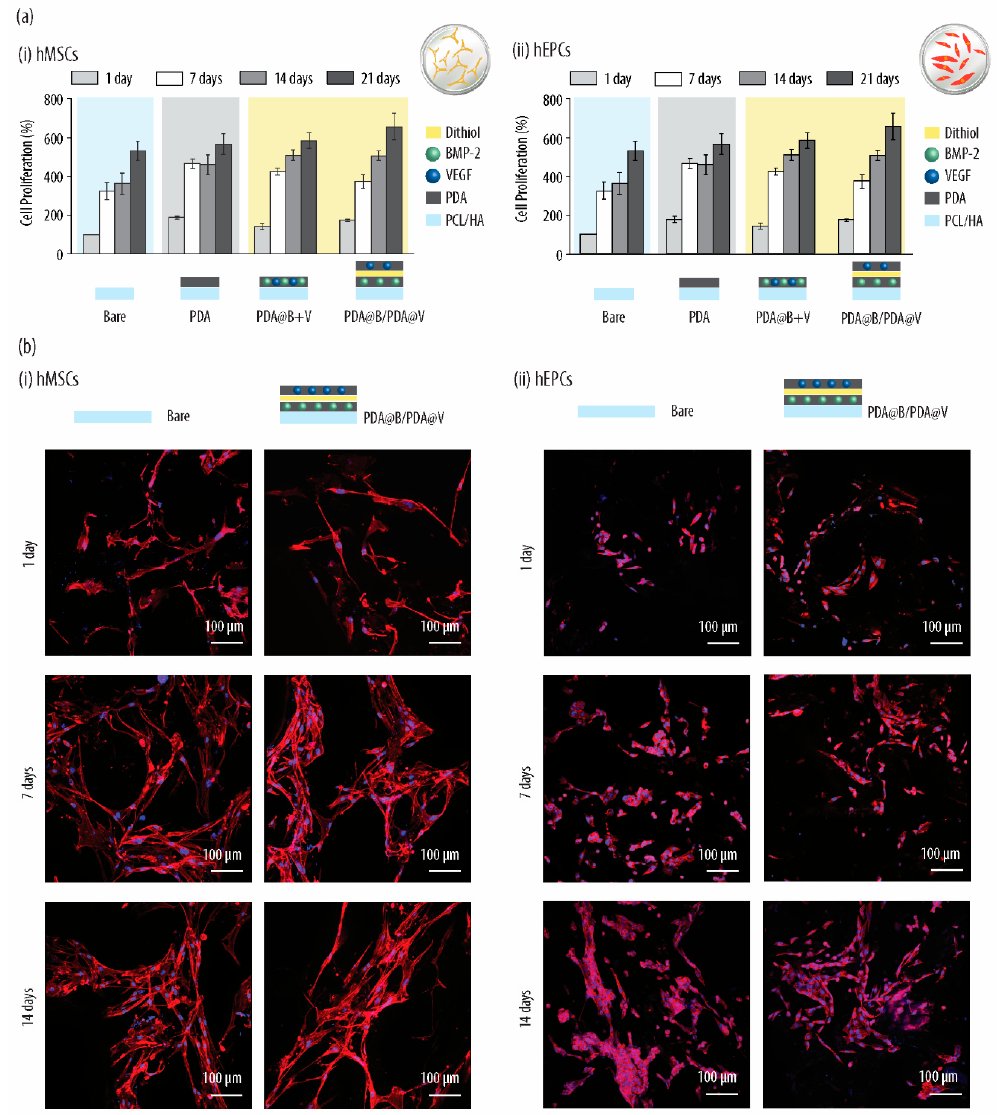
Figure 3. ( a ) Proliferation of human mesenchymal stem cells (hMSCs) ( i ) and human endothelial progenitor cells (hEPCs) ( ii ) onto PCL/HA scaffolds (bare), surface coated with polydopamine